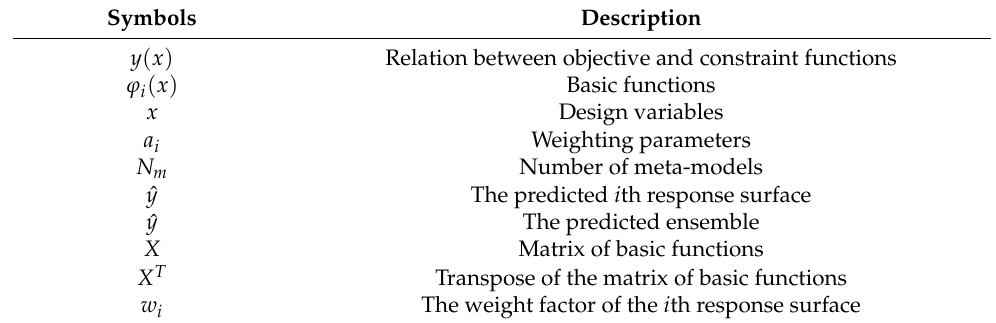
Table 3. Symbols in Equations (33)–(38).